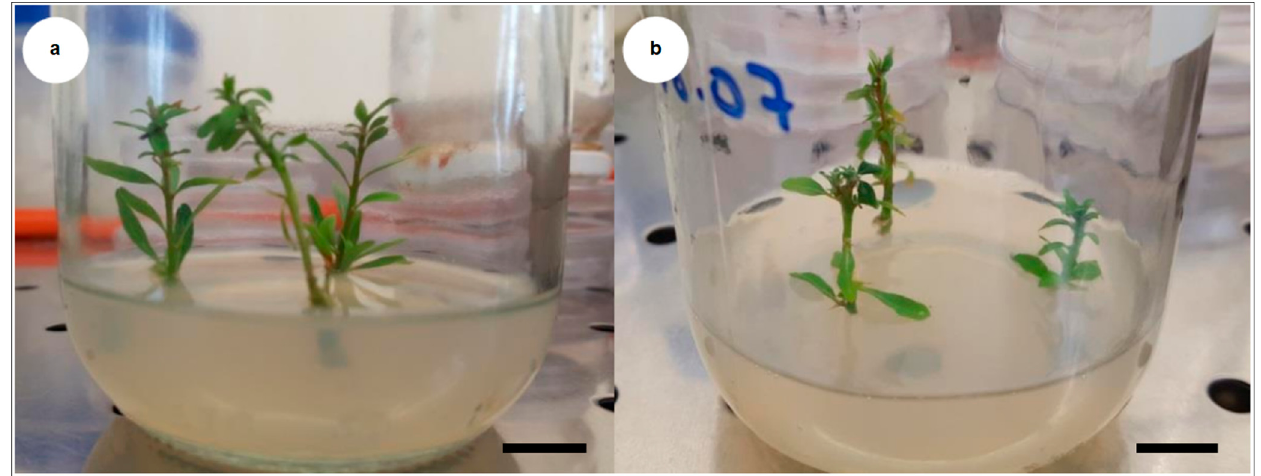
Figure 5. Adventitious shoots of argan used for rhizogenesis experiments. ( a ) genotype “R’zwa” and ( b ) genotype “Mejji”. Bars correspond to 1 cm.